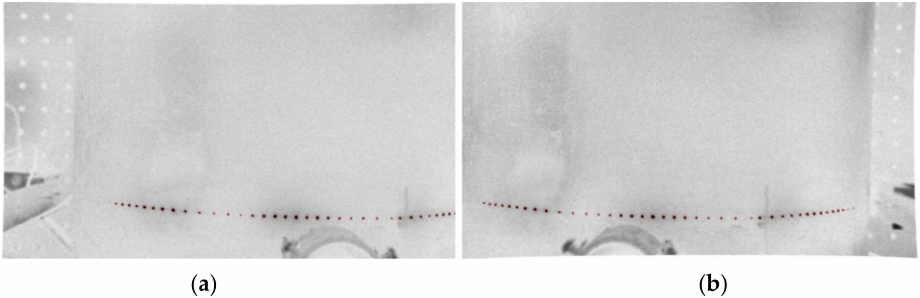
Figure 11. ( a ) Extraction of feature points for left camera; ( b ) extraction of feature points for right camera.